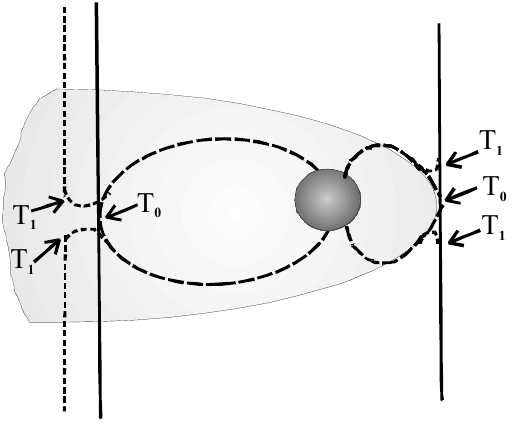
Figure 6. Merging geometry for frontside and flank. Field lines (dashed) from the polar cap are shown going (right) to the frontside merging point, and (left) to the flank merging point. The vertical lines are IMF –ve B z . Merging time is T 0 for both types of merging, and T 1 mark the magnetic field kinks shortly after merging. The magnetopause is shown as a lightly shaded surface.